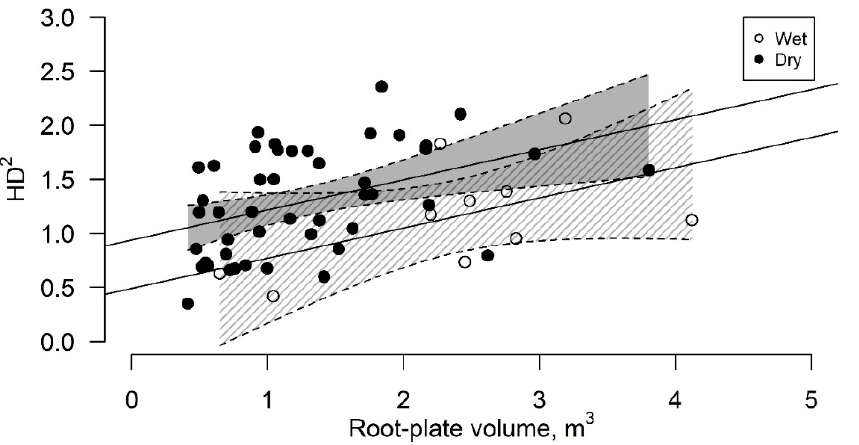
Figure 4. Tree wind-resistance indicator (HD 2 ) in relation to root-plate volume on wet and dry mineral soils. The grey area denotes 95% confidence interval.